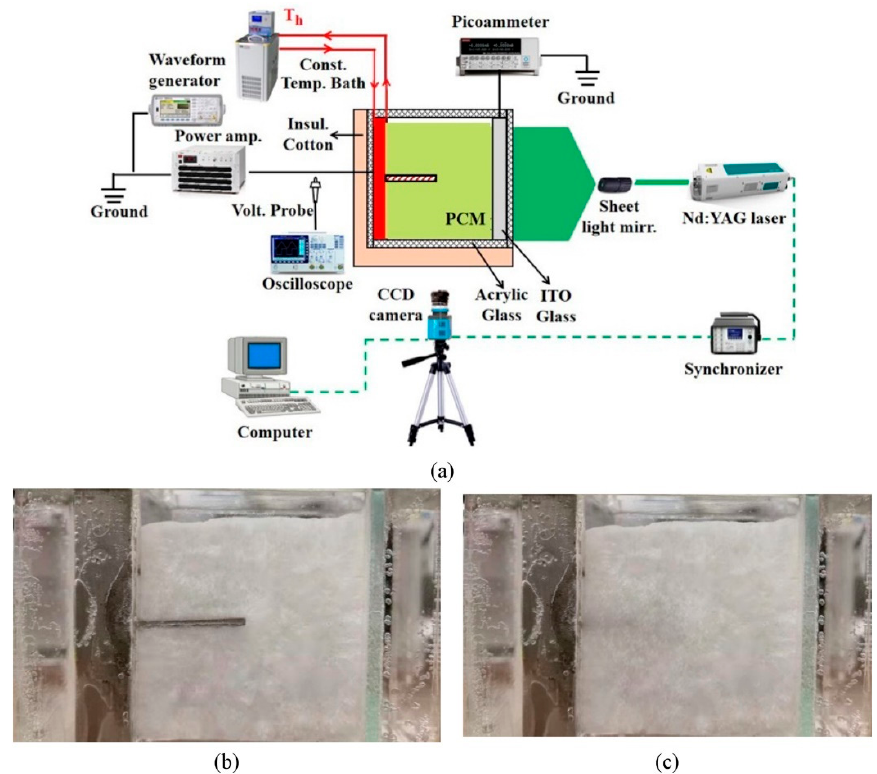
Figure 33. ( a ) The functional diagram; ( b ) enclosure with fin; ( c ) enclosure without fin. Reproduced from [118] with permission from Elsevier.